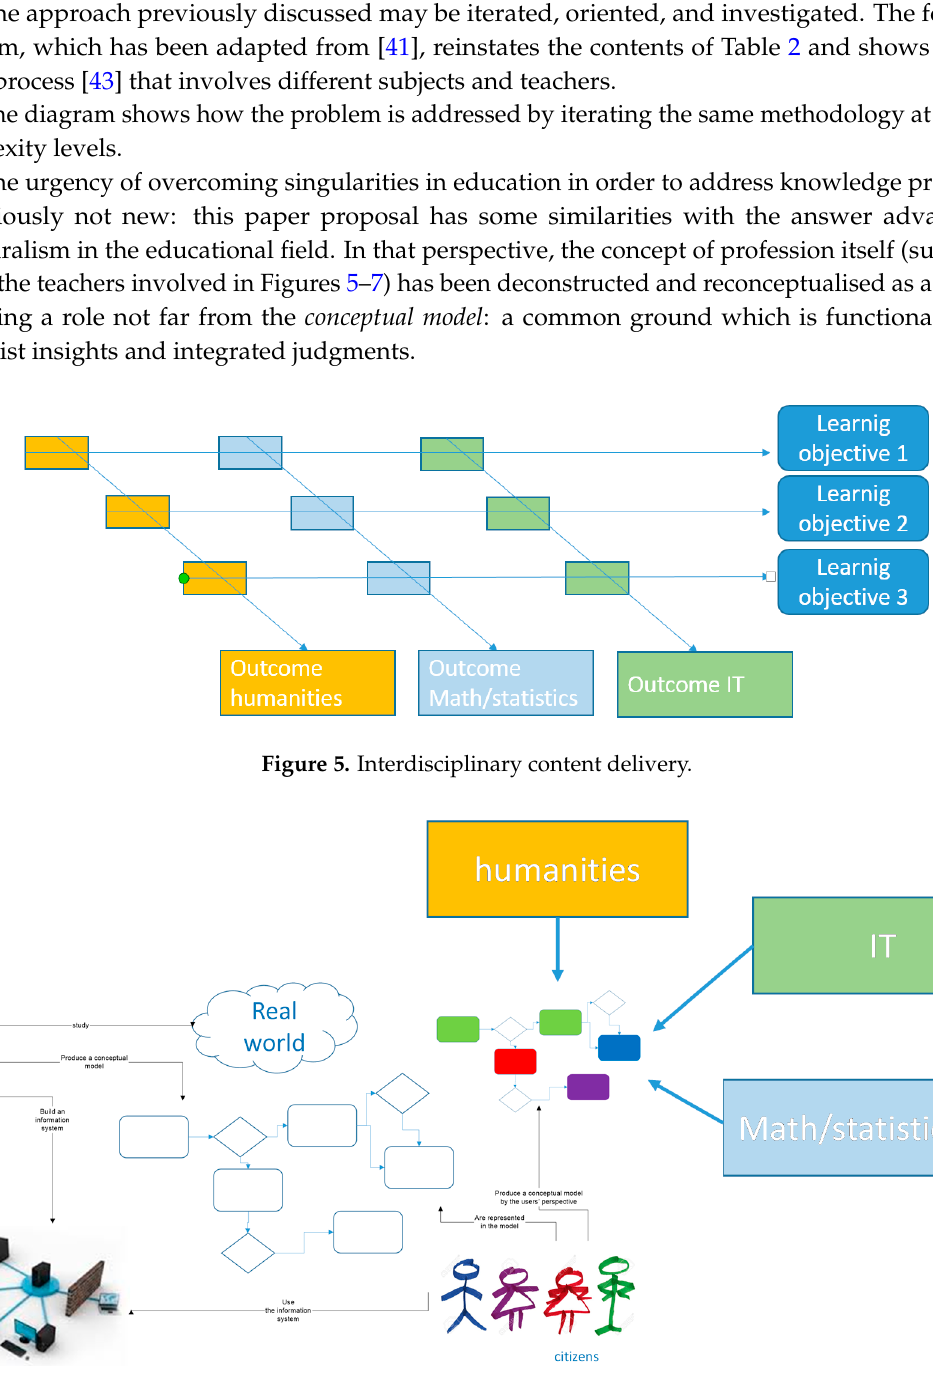
Figure 6. The contribution of conceptual models to an interdisciplinary education approach.